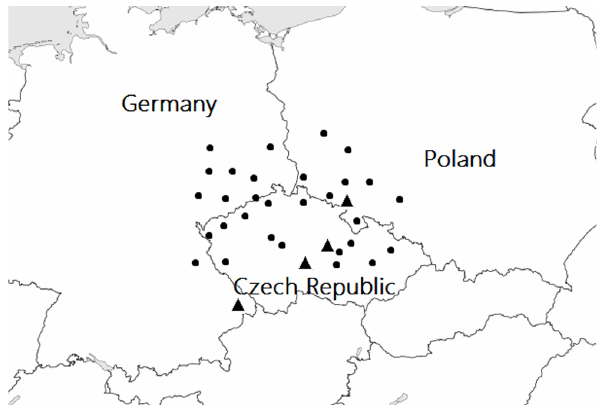
Fig. 1. The Black Triangle area. The 30 surface stations with mete- orological observations are marked as dots, and the 4 EMEP stations marked as